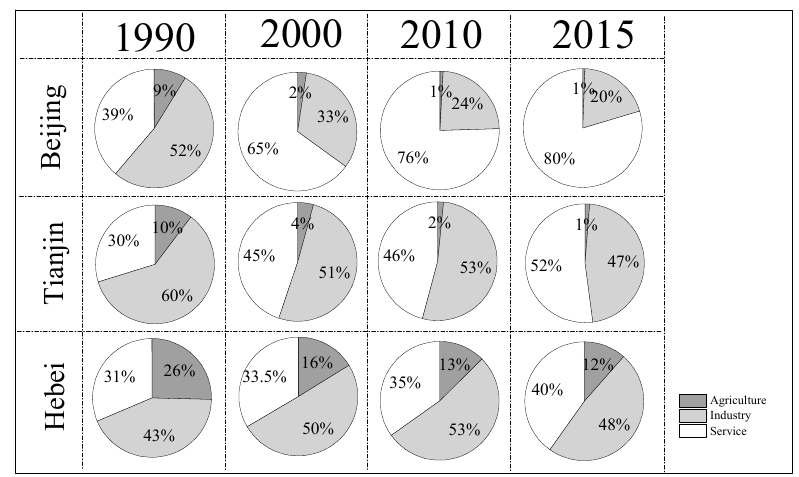
Figure 5. Gross domestic product (GDP) compositions of Beijing, Tianjin, and Hebei.